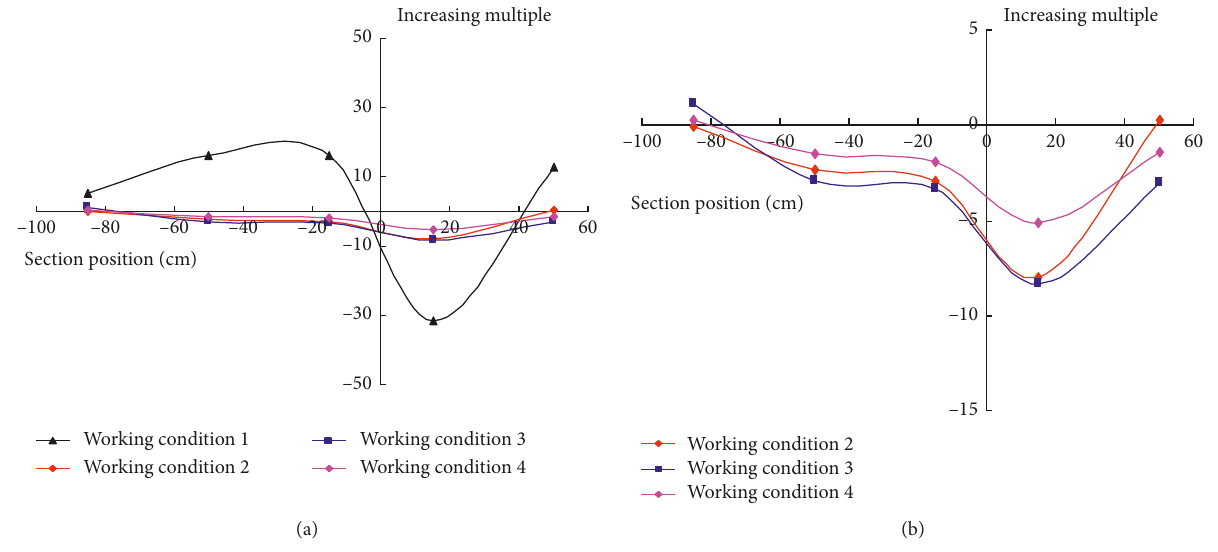
Figure 8: Increasing multiple of contact pressure. (a) Working conditions 1 to 4. (b) Working conditions 2 to 4. Table 7: Antibreaking effect of contact